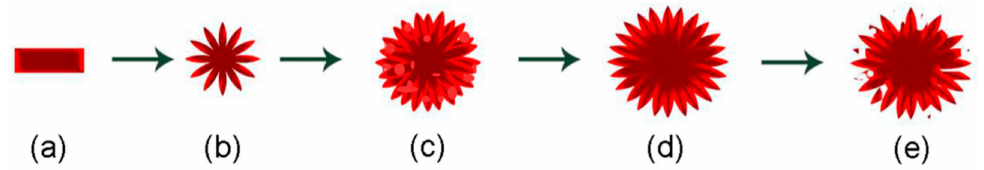
Figure 3. Illustration depicting the formation mechanism of 3D hierarchical nanospheres, ( a – e ) represents the evolution of material morphology with the growth time.